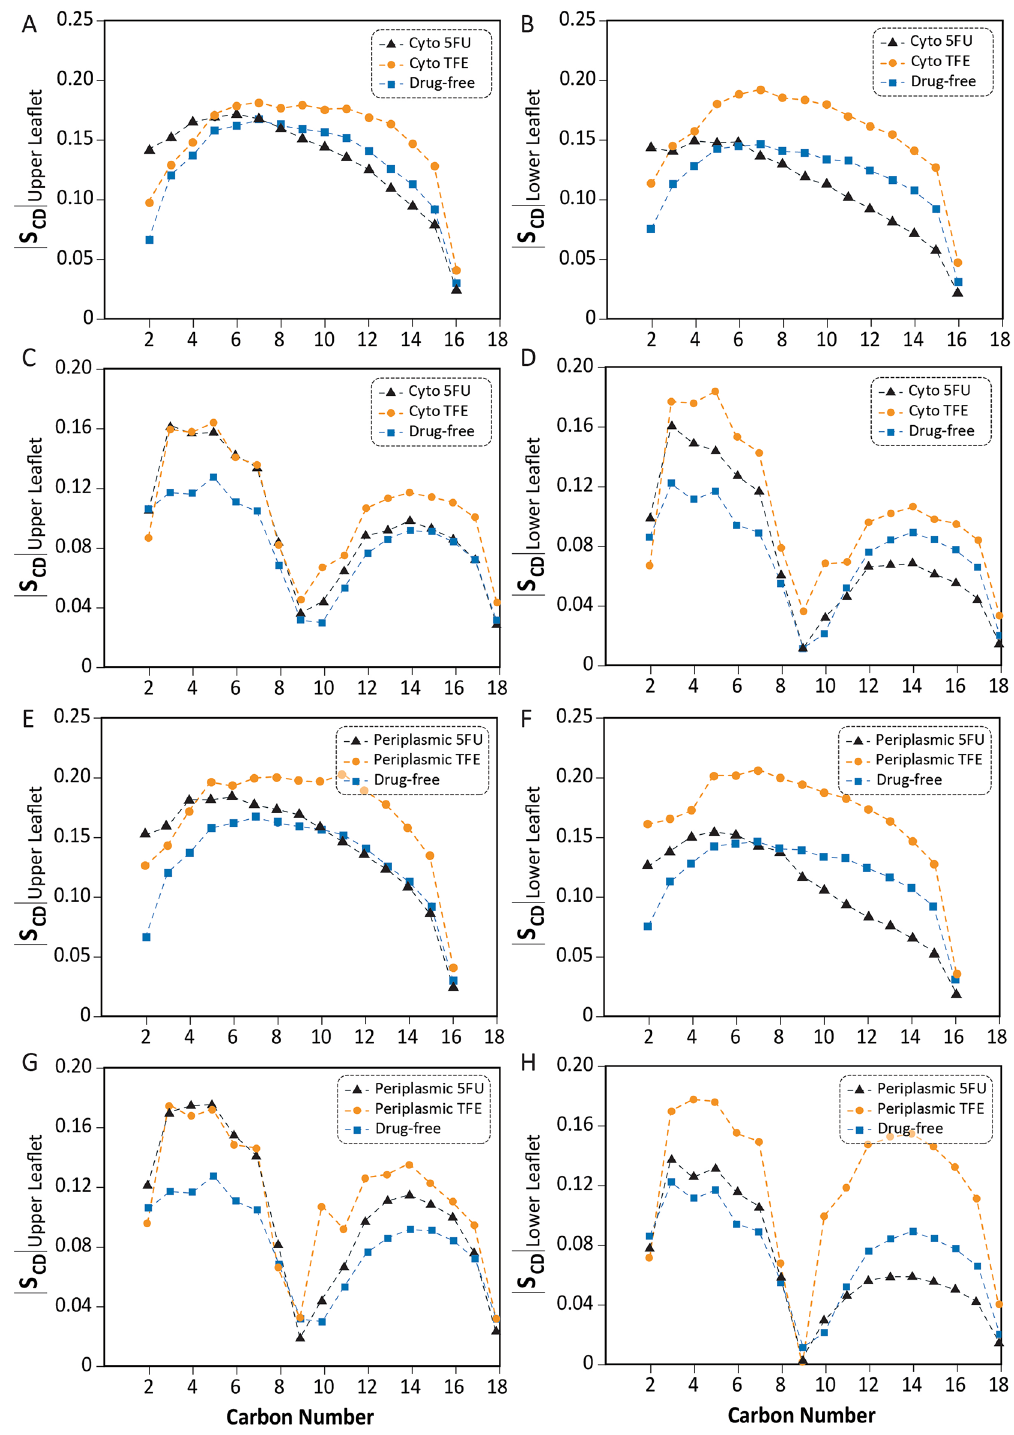
Figure 2. Effect of 5-FU and TFE adsorption to the bilayer from the cytoplasmic and periplasmic sides. Sn-1 order parameter ( A , B , E , F ) and Sn-2 order parameter ( C , D , G , H ) of a POPE bilayer containing MscL are affected by both amphipaths. Effect of the drugs on Sn-1 and Sn-2 when added to the cytoplasmic side ( A – D ) and periplasmic side ( E – H ). The vertical axes represent the absolute values of calculated deuterium order parameters which show that TFE molecules interact with the lipid molecules leading to an increase of the order parameters. While the presence of 5-FU increases the order parameter for carbon atoms located close to the lipid/water interface its presence decreases the order parameter for those in the bilayer center. Data represents mean ± SD of 3 replicate simulations using 2% v/v TFE and 25 mM